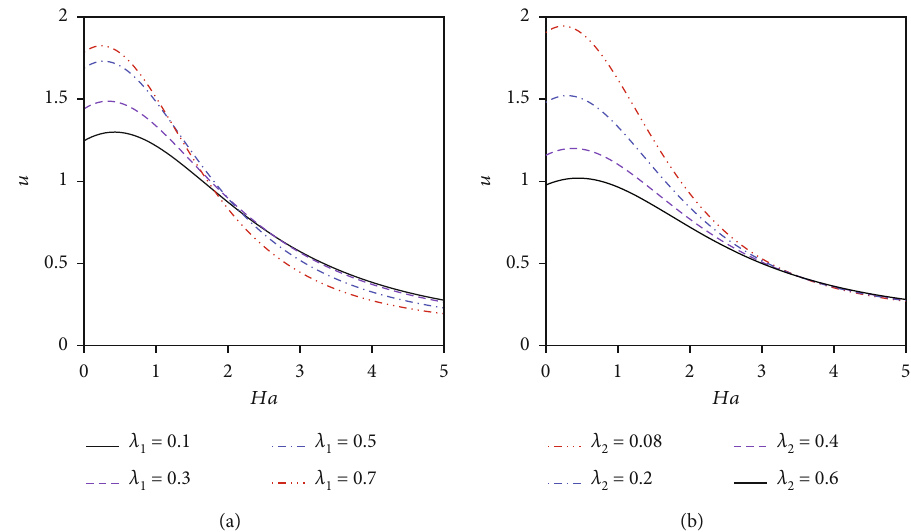
Figure 5: Dimensionless velocity distribution at r = 0 in a circular microchannel ( λ